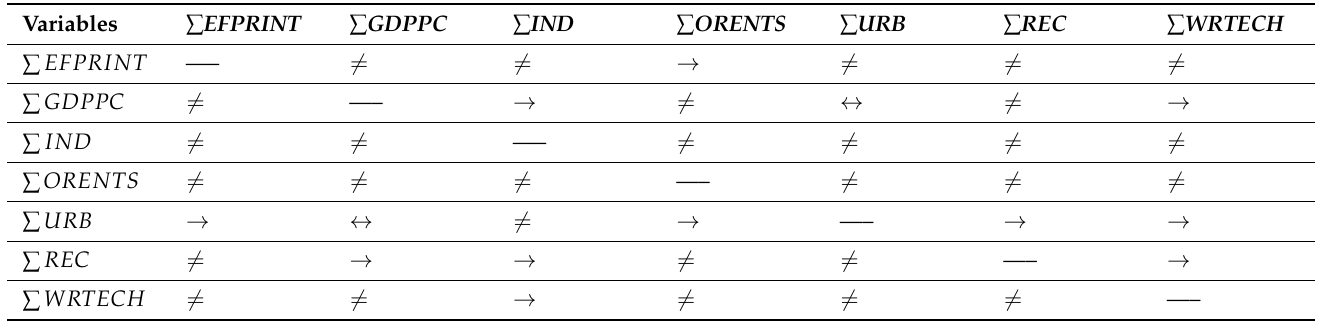
Table 8. VAR Granger causality estimates.